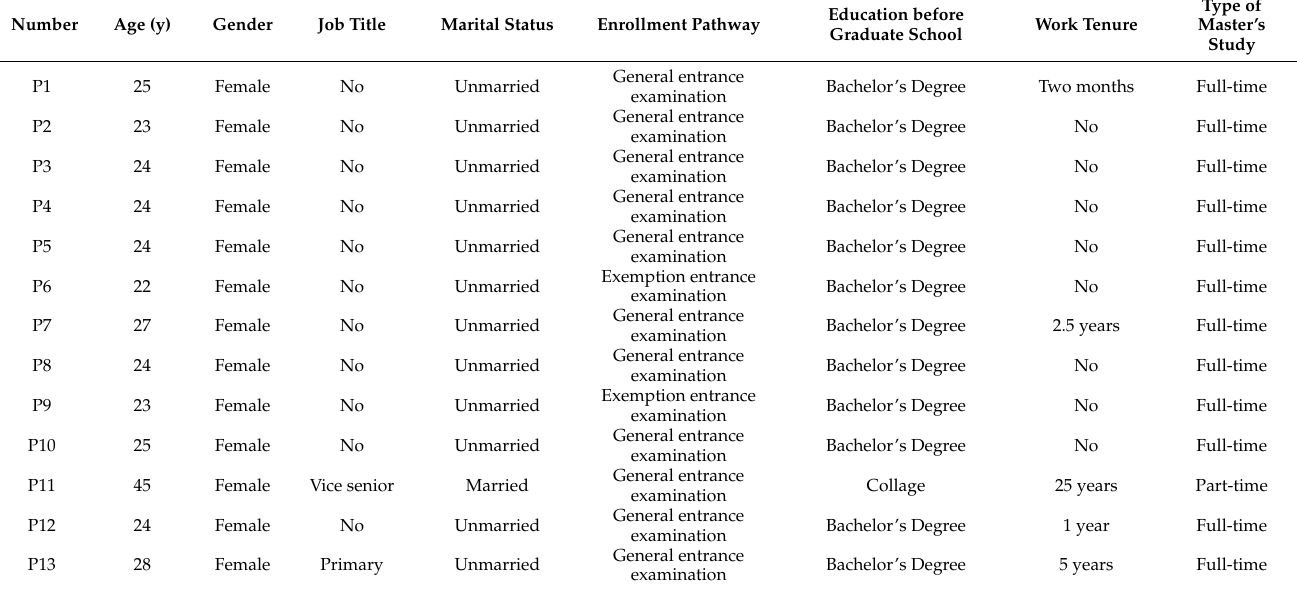
Table 1. Characteristic of nursing postgraduate